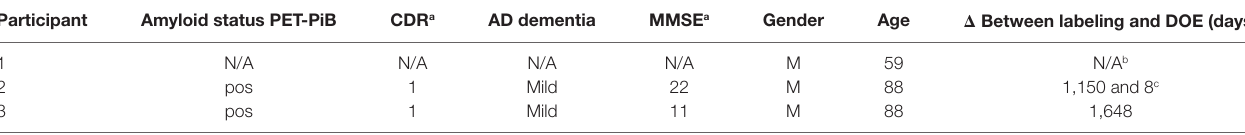
TaBle 1 | Patient demographics for SILK-SIMS imaging of A β